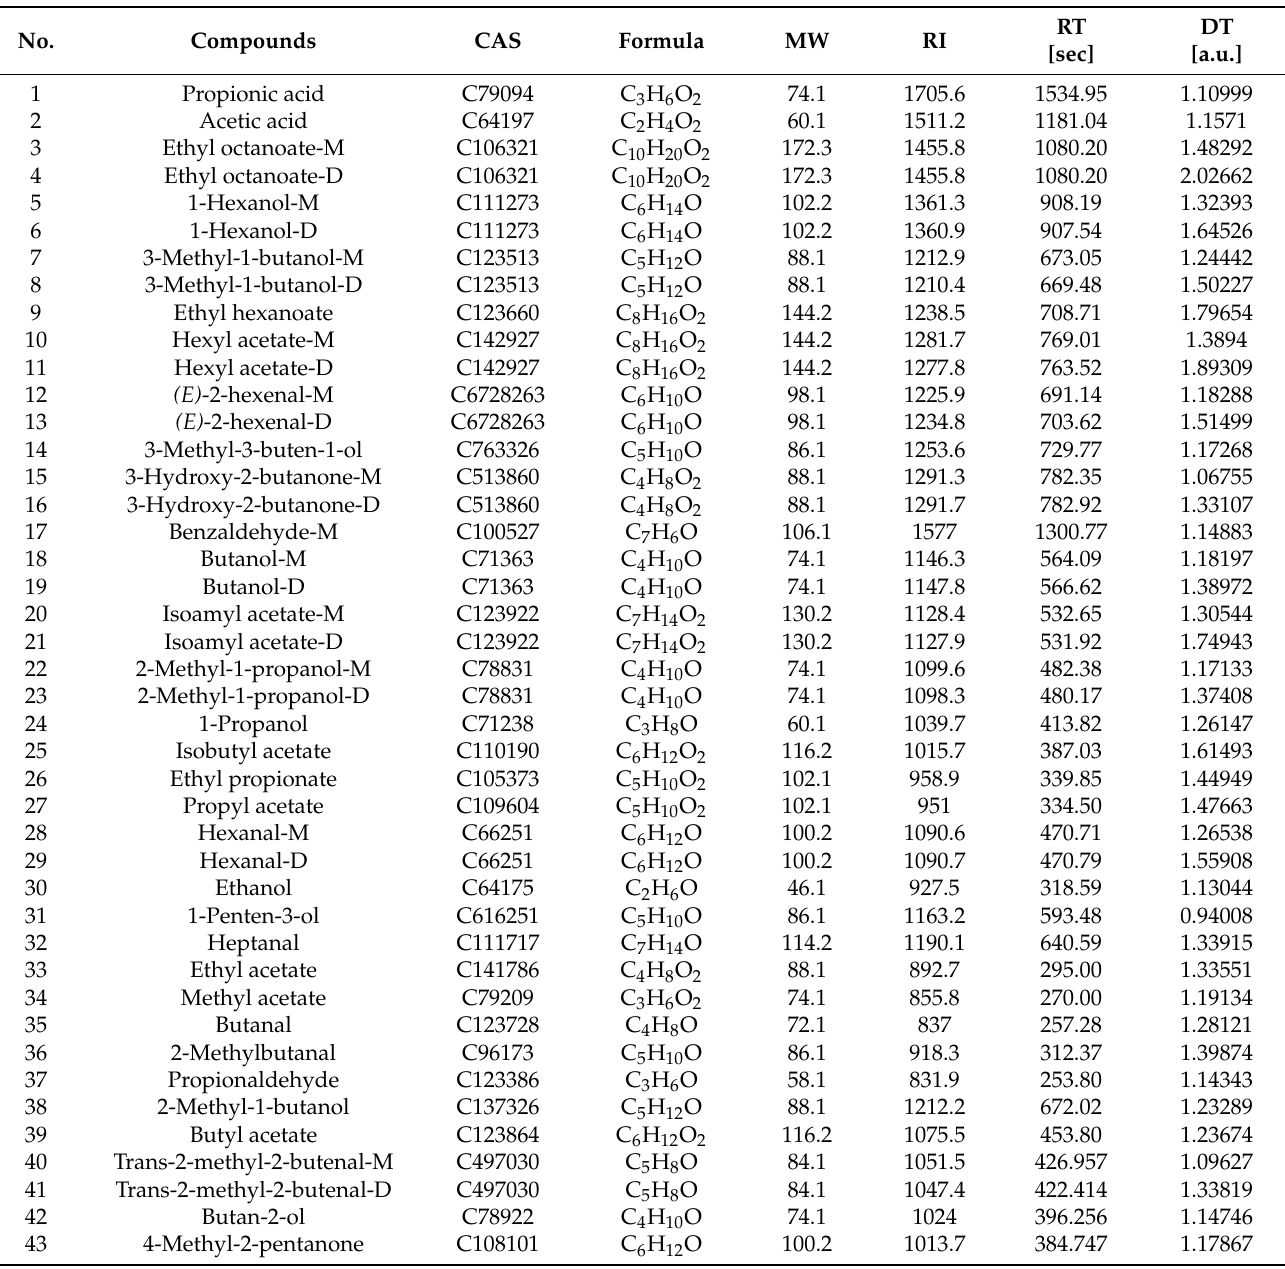
Table 2. GC-IMS integration parameters of volatile compounds detected in cherry fruits and their